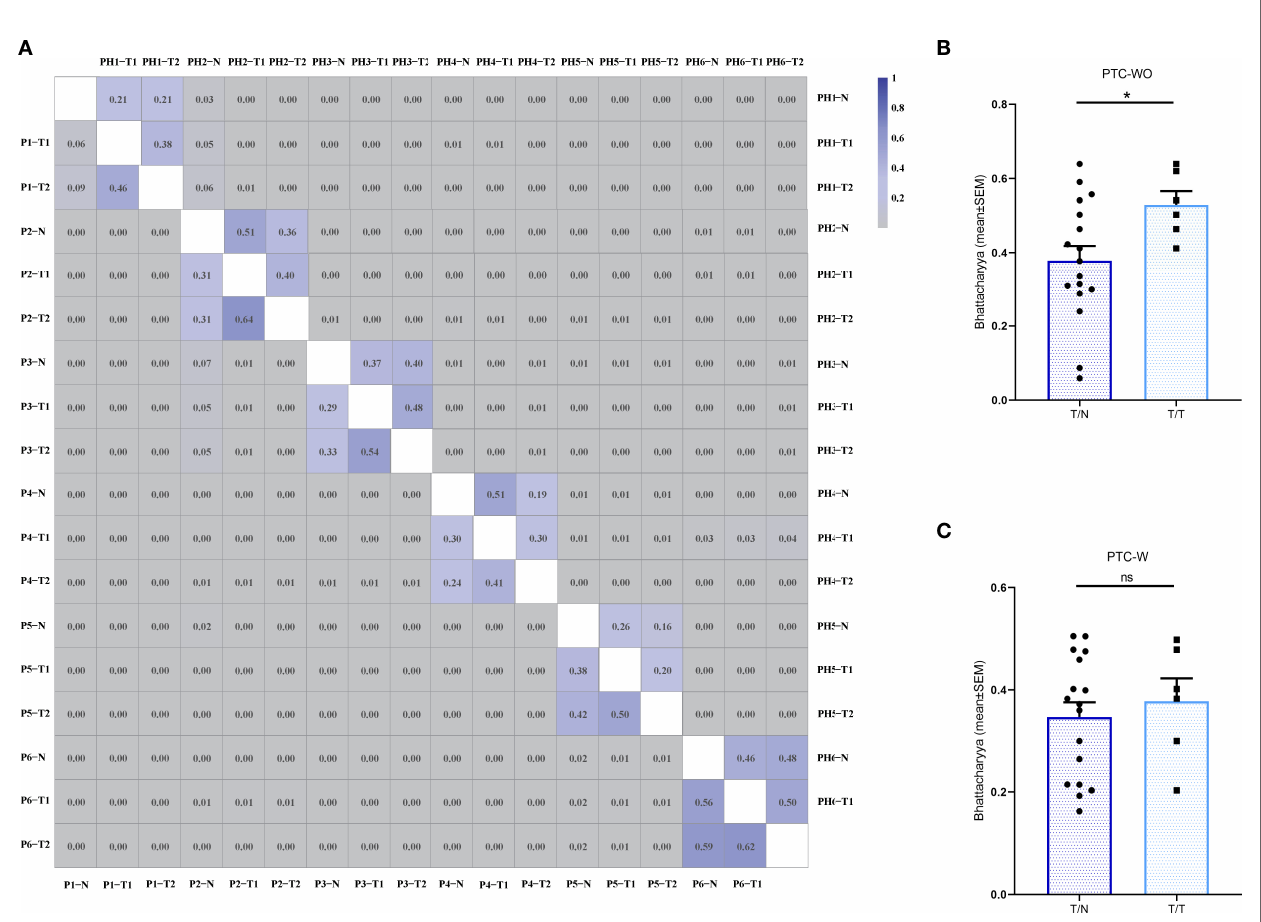
FIGURE 4 | The Bhattacharyya coef fi cient of the TCR repertoire across different samples in PTC with and without HT. (A) The Bhattacharyya coef fi cient between different samples in PTC with and without HT. The color scales represent for the Bhattacharyya coef fi cient variation. Two triangles of the heatmap demonstrate the Bhattacharyya coef fi cient landscape between different samples in PTC with and without HT, respectively. (B) The Bhattacharyya coef fi cient between tumor (T) and normal (N) samples as well as between different tumor samples in each PTC without HT. (C) The Bhattacharyya coef fi cient between tumor (T) and normal (N) samples as well as between different tumor samples in each PTC with HT. *P < 0.05; ns, not signi fi